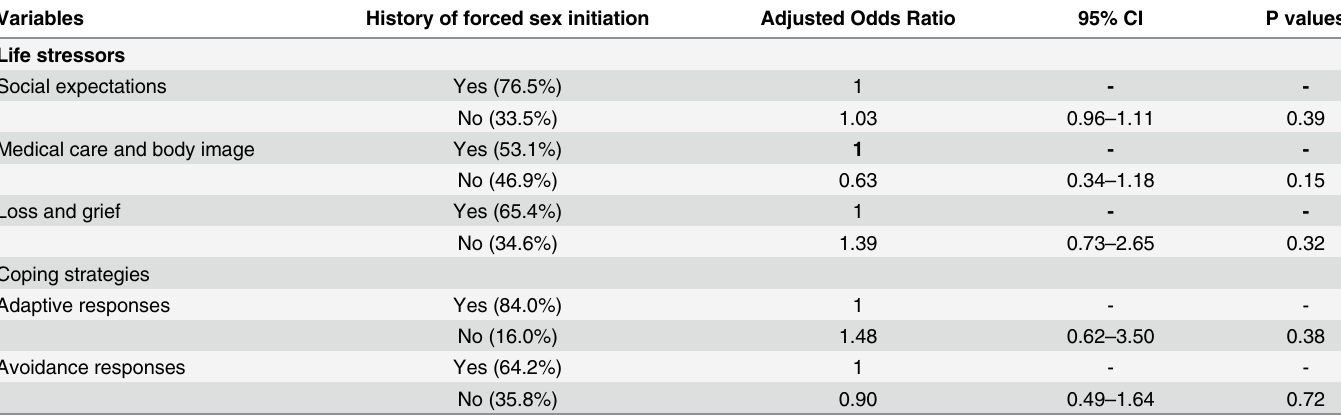
Table 5. Logistic regression model determining stressors and coping strategies used by adolescents with a history of forced sexual